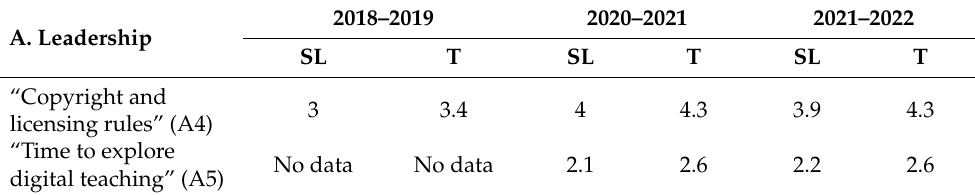
Table 2. Descriptive statistics on Leadership.